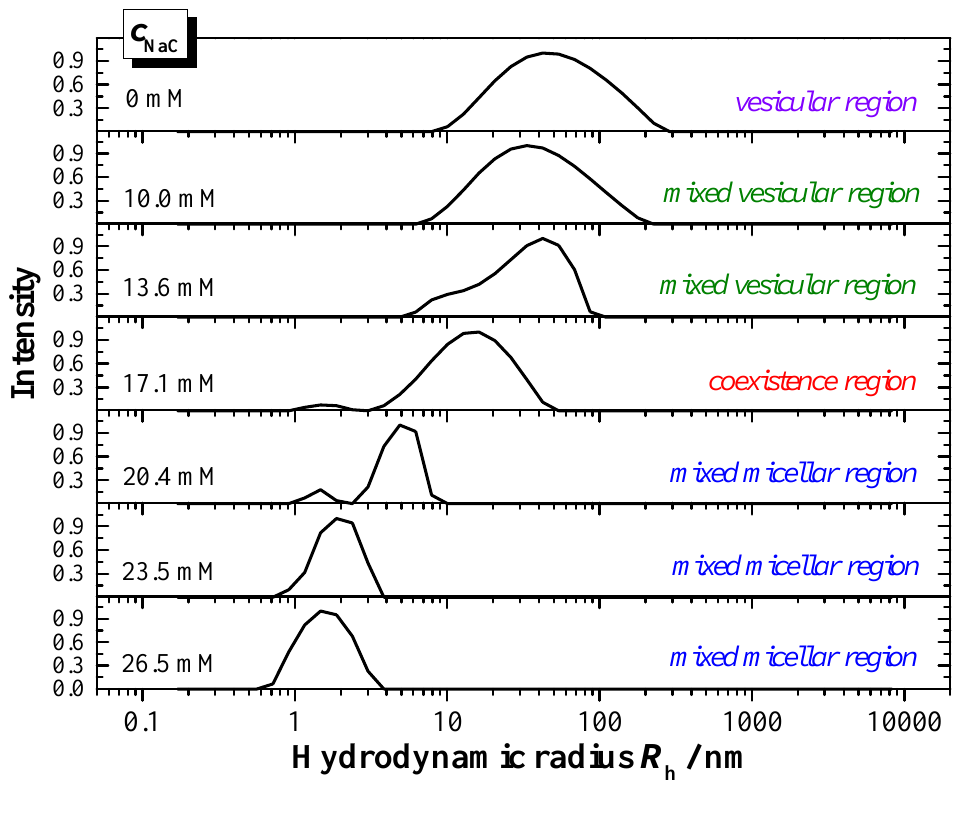
Figure 8. Results of DLS (dynamic light scattering) solubilisation experiments: Solubilisation of DPPC vesicles at 6 mM dispersed in water ( pH 7.5) with NaC at a concentration of 150 mM at T = 55 ° C. Titration volume: 20 μ L